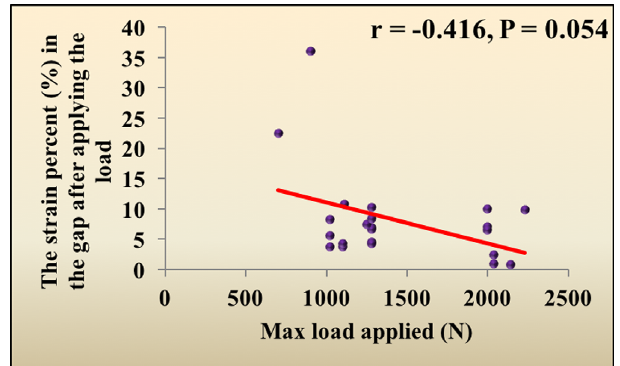
Figure 2. The correlation between the maximum load applied and the strain percent in the gap after applying the